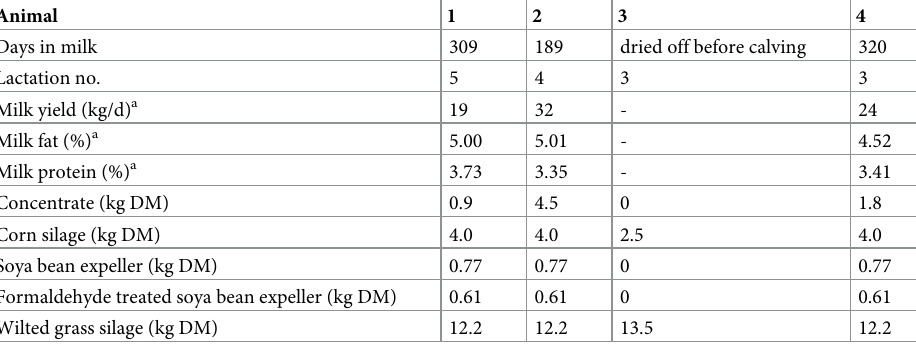
Table 1. Characteristics of the four rumen-fistulated Holstein Friesian cows. Animal Days in milk 309 Lactation no. Milk yield (kg/d) a